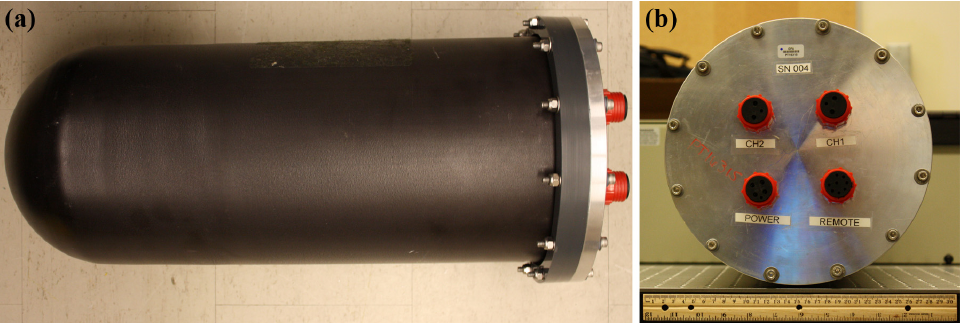
Figure 5. Submersible version of the Underwater Sound Recorder. (a) PREVCO submersible housing; (b) external waterproof